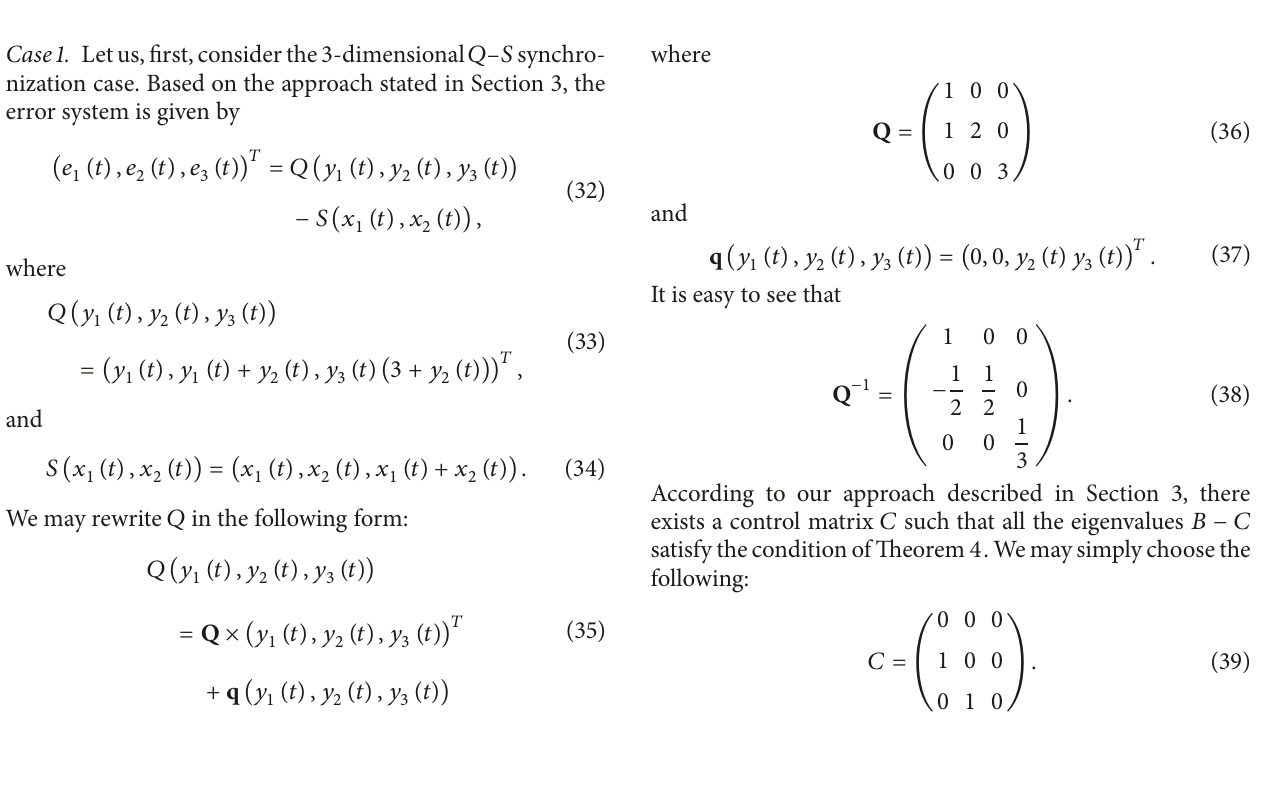
Figure 2: Phase portraits for the fractional generalized H´enon map with (𝑎 2 ,𝑏 2 ) = (0.99,0.2) , 𝛽 = 0.984 and (𝑦 1 (0), 𝑦 2 (0),𝑦 3 (0)) = (0.1,0.2,0.5)